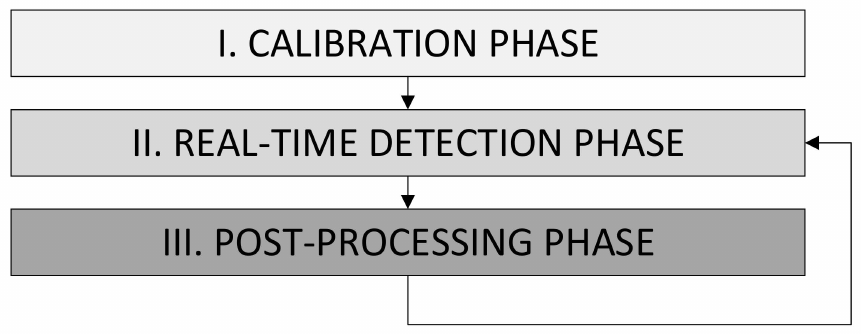
Figure 3. Phases of the proposed indoor positioning